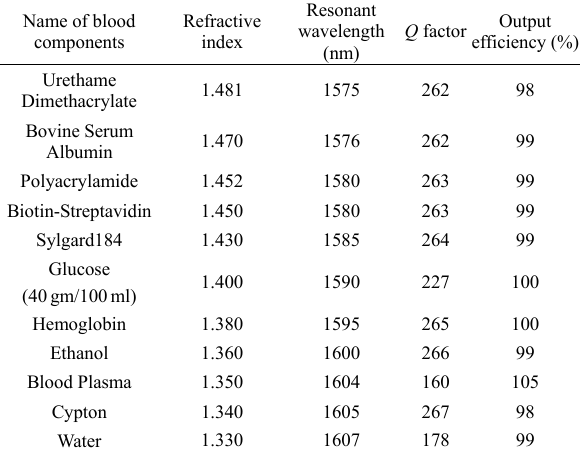
Table 2 Input refractive index, resonant wavelength, quality factor, and output efficiency for different blood components in blood.